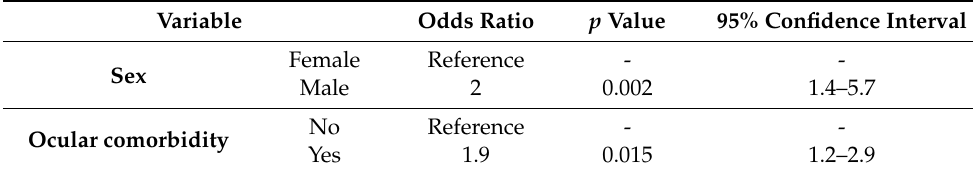
Table 6. Logistic regression. After multivariate analysis of the variables that might be associated with primary RD redetachment, results are shown for variables found to be significant. Results are represented as odds ratios, 95% confidence intervals and p